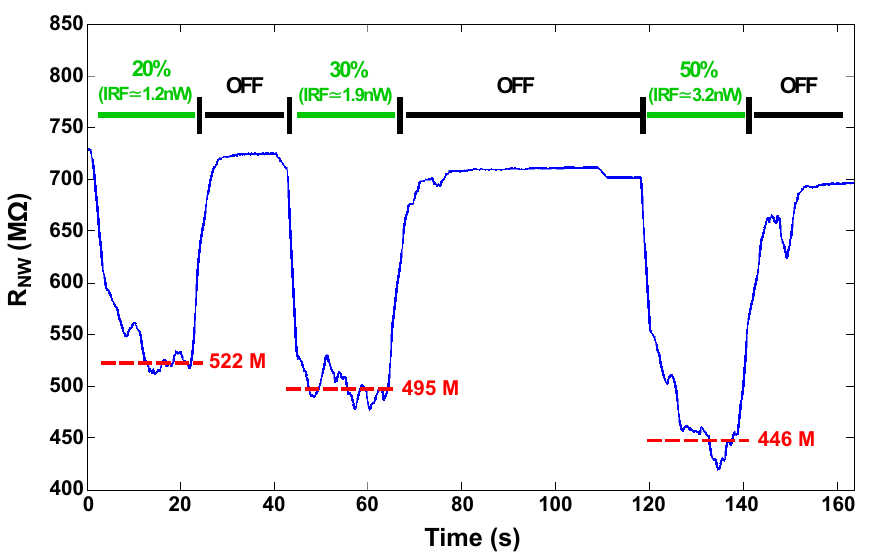
Figure 9. Real-time behaviour of the R NW of ZnO-NW A when it is exposed to the UV source placed at 6cm and working at 20%, 30% and 50% of the maximum irradiance power. The IRF-UV corresponds to about 1.2nW, 1.9nW, 3.2nW,